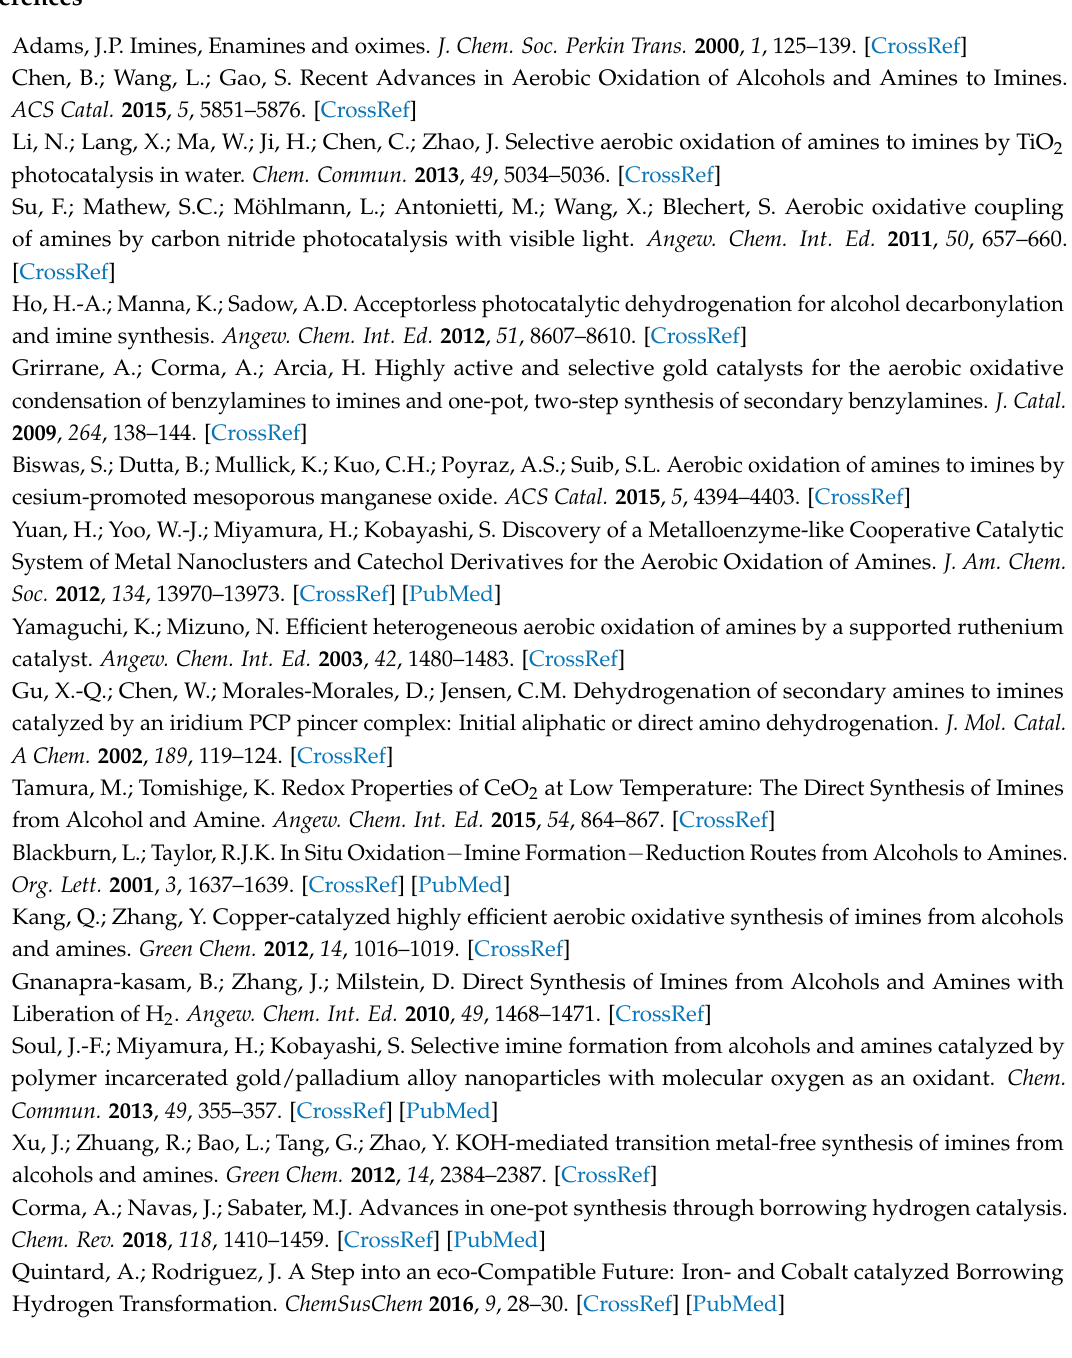
analysis; Table S5: Screening of solvents; Table S6: Screening of reaction temperature; Table S7: Screening of CoO x @NC-T catalysts; Table S8: Effect of amount of benzyl